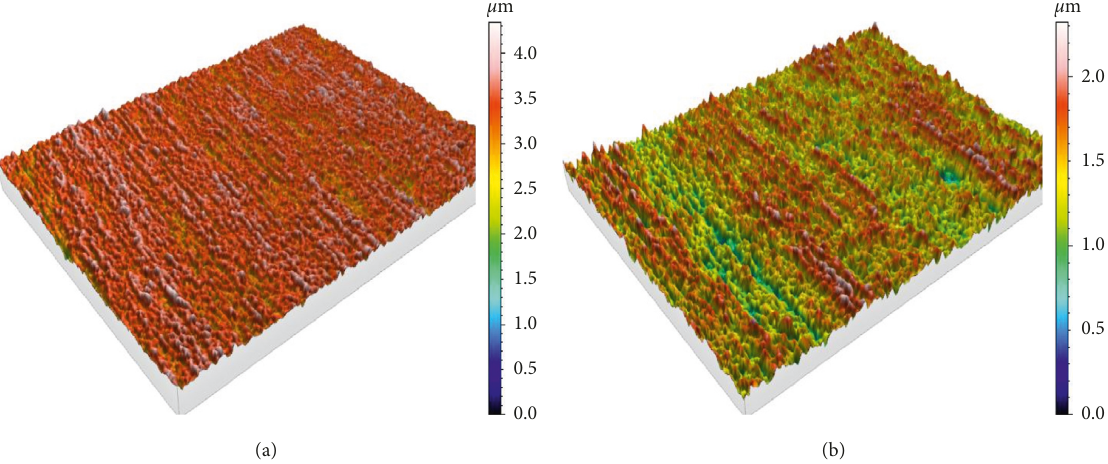
2 , 180min, i 0.05A cm (cid:31) (cid:31) · −